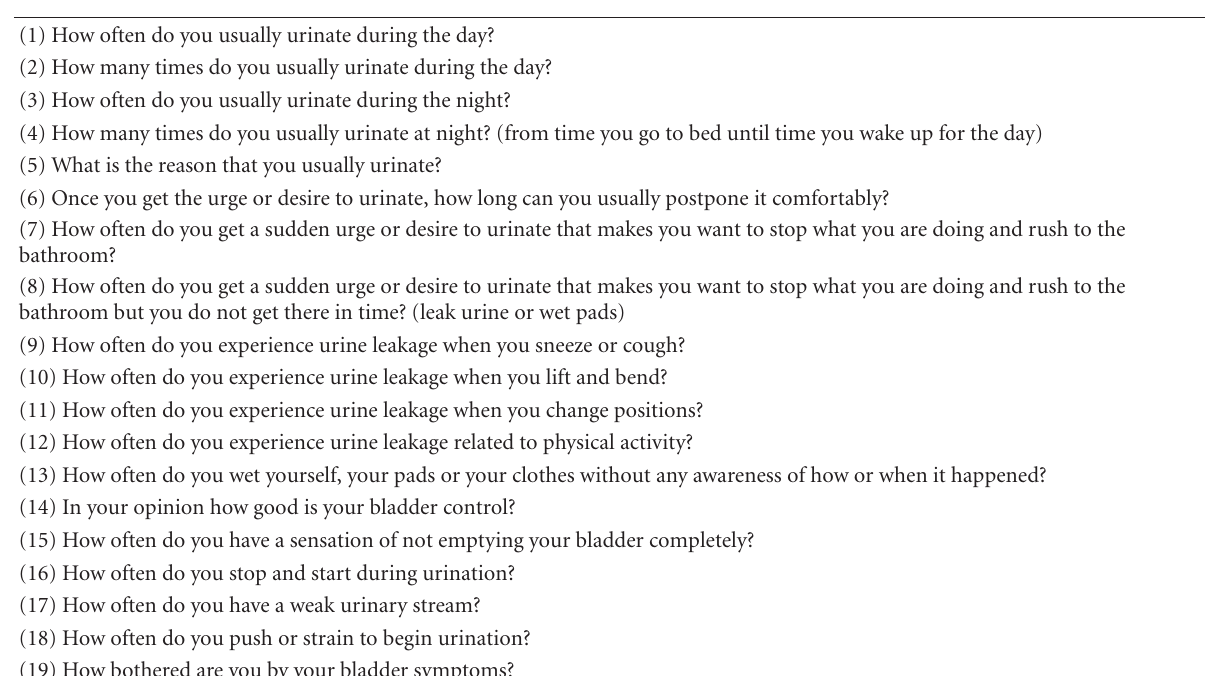
Table 3: Systemic clinic